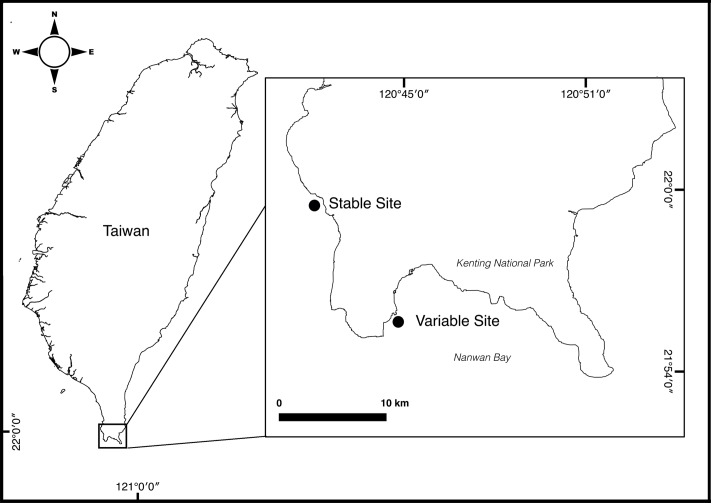
Study sites in Nanway Bay, southern Taiwan.Both sites are located within Kenting National Park: Variable Site (VS) in the power plant outlet (21°55'53.7"N 120°44'42.7"E) and Stable Site (SS) in Wanlitong (21°59'43.9"N 120°42'23.2"E).